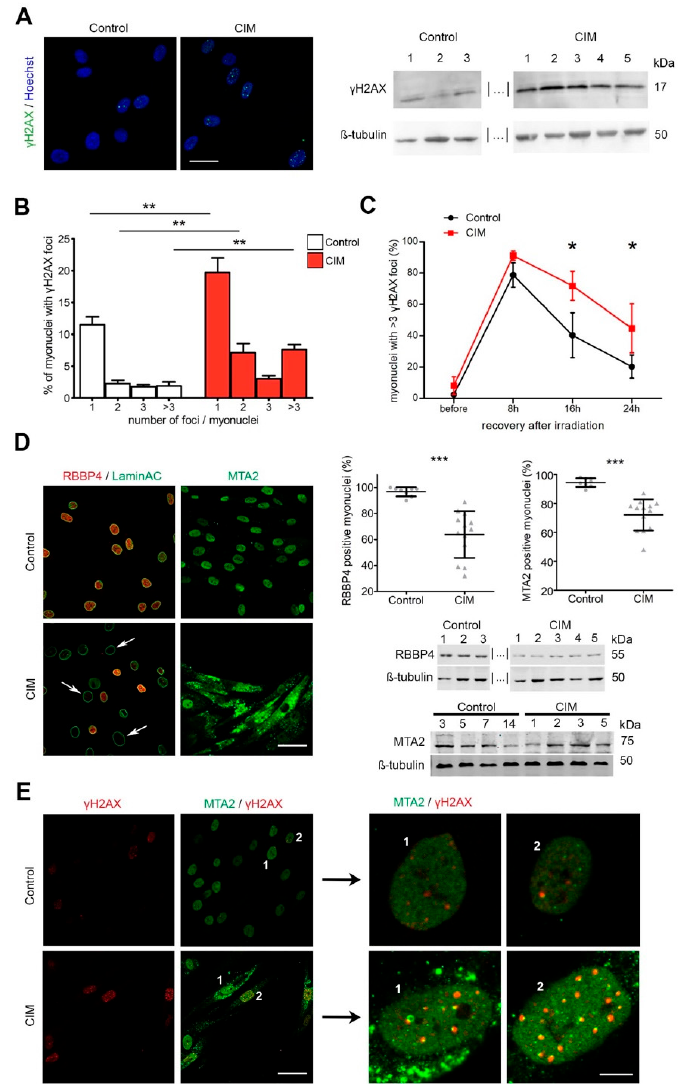
Figure 3. DNA-double strand breaks (DSBs) and impaired nucleosome remodeling and deacetylase (NuRD)-complex in CIM-MuSC. ( A ) Immunofluorescent staining for γ H2AX (green) and Western blot analysis of γ H2AX in CIM-MuSC and controls. Two other samples, indicated by | . . . |, are shown in Figure 5. ( B ) Quantification of myonuclei with DSBs ( γ H2AX foci >3) in CIM-MuSC ( n = 10) and controls ( n = 8). ( C ) Analysis of γ H2AX foci accumulation kinetics shows reduced repair of irradiation-induced DSBs in CIM-MuSC ( n = 4 for CIM- and control MuSC; 8 h: CIM 91%, control 78%; 16 h: CIM 72%, control 40%, p < 0.05; 24 h: CIM 40%, control 20%, p < 0.05). ( D ) Immunofluorescent staining for NuRD components RBBP4 (red) (CIM, n = 13, mean 64%; control, n = 8, mean 97%; p < 0.001) and MTA2 (green) (CIM, n = 13, mean 72%; controls, n = 8, mean 94%; p < 0.001) and Western blot analysis. Arrows: RBBP4 negative myonuclei. ( E ) Co-localization of γ H2AX (red) and MTA2 (green) by immunofluorescence in myonuclei. MTA2 accumulated close to DSB The right panel shows a magnification of the cells marked with 1 and 2 on the left panel. Data information: In ( A , D ), scale bar for all images: 50 µ m. In ( E ) scale bar of the images on the left: 50 µ m; scale bar of zoomed images on the right: 5 µ m. All values are expressed as mean ± SEM. In ( B , D ), at least 200 nuclei/cell population were counted for quantification; data were analyzed by Mann–Whitney U test. In ( C ), data were analyzed using paired t-test. * p < 0.05, ** p < 0.01, *** p < 0.001.